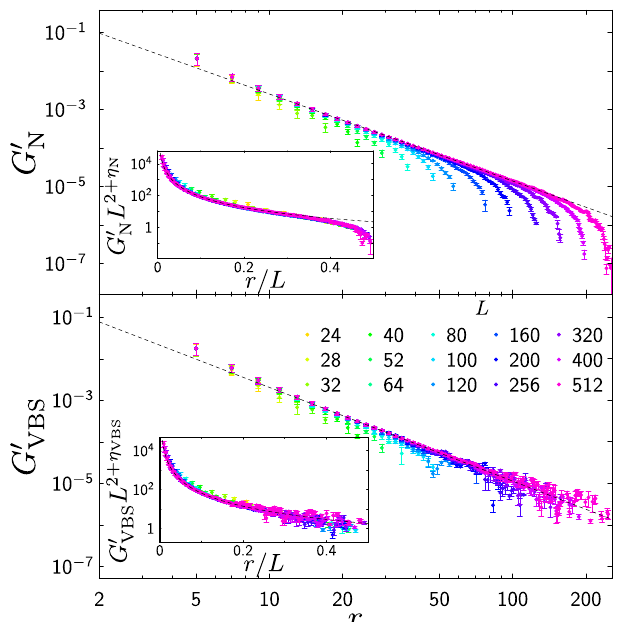
r Þ = d r FIG. 9. Derivatives of Néel and VBS correlators, d G N é el ð r Þ = d r . The main panels show raw data and power-law and d G VBS ð 0 . 259 ð 6 Þ and η 0 . 25 ð 3 Þ . fits (dashed lines) with η N é el ¼ VBS ¼ The insets show scaling collapse of L 2 þ η G 0 versus r=L , with the same values for η . N é el ; VBS